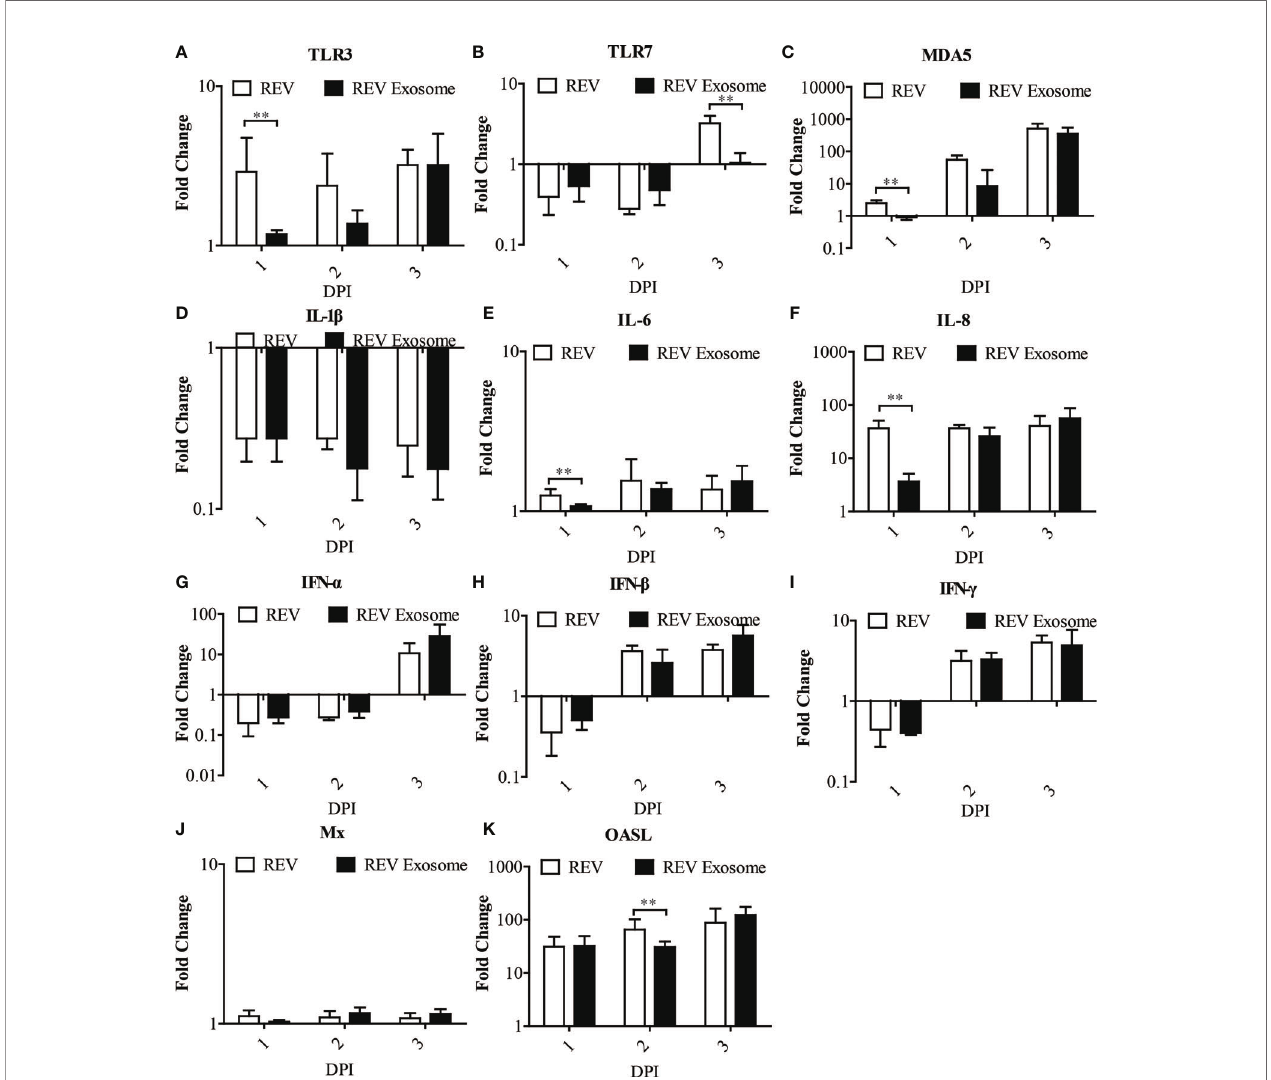
FIGURE 7 | Expression pro fi les of immune-related genes in the livers from infected chicks. Liver samples from chickens were collected at 1, 2, and 3 dpi. The inducible gene expression levels in the cells were tested using real-time quantitative reverse transcription polymerase chain reaction analysis. Fold change was calculated by comparing the experimental group with controls at the same sampling point, and relative expression levels were normalized to the b -actin gene and calculated using the 2 − △△ Ct method. Data are the means across three independent experiments, and each experiment was analyzed in triplicate. Results are expressed as means ± SDs ( n = 3). **Indicates signi fi cant difference ( p < 0.01) between the two experimental groups. (A – K) Expression levels of TLR3, TLR7, MDA5, IL-1 b , IL-6, IL-8, IFN- a , IFN- b , IFN- g , OASL, and Mx in infected